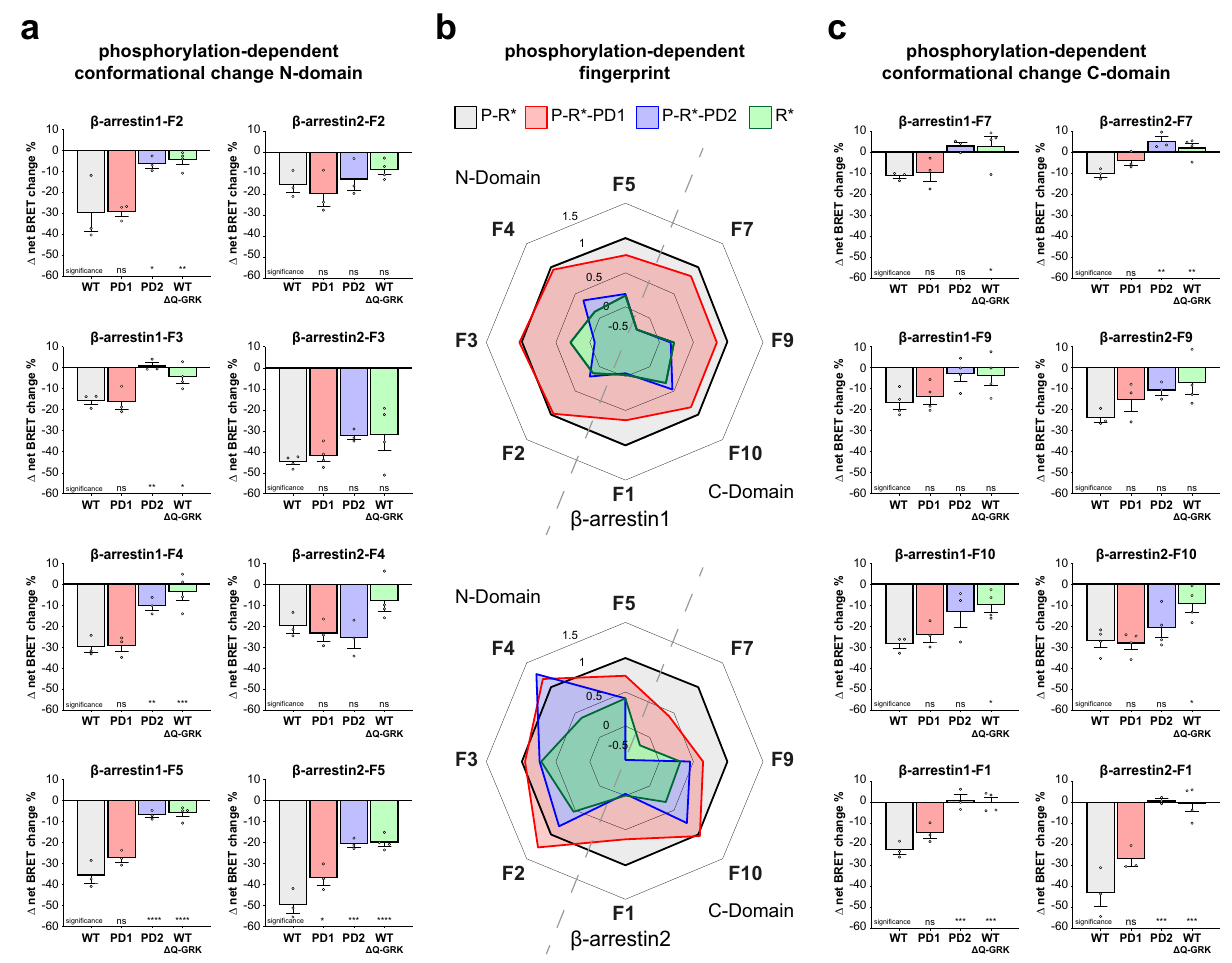
Fig. 5 | The PTH1R phosphorylation state induces speci fi c conformational rearrangementsin β -arrestin1 and2.a Conformational changeof β -arrestin1and 2 biosensors labelled in the respective N-domain, interacting with PTH1R-WT, PTH1R-PD1, PTH1R-PD2 in HEK-WT, or PTH1R-WT in Δ Q-GRK. In short, HEK-WT or Δ Q-GRK cells were transfected with either an untagged PTH1R-WT, PTH1R-PD1, or PTH1R-PD2 expression construct and one β -arrestin conformational change bio- sensor,FlAsH-labelledandstimulatedwith3 µ MPTH(1-34).Conformationalchange dataareshownas Δ netBRETchangeinpercent,meanofatleastthreeindependent repetitions (all measurements in Δ Q-GRK n =4; β -arrestin2-F3 PTH1R-WT, -PD1 n =4;allotherconditions n =3)+SEM.Thestatisticalsigni fi cancewascalculatedby one-wayANOVA, followedbyatwo-sided Dunnett ’ stest(*, p <0.05;**, p <0.01;***, p <0.001; ****, p <0.0001). The complete results of the statistical analysis are